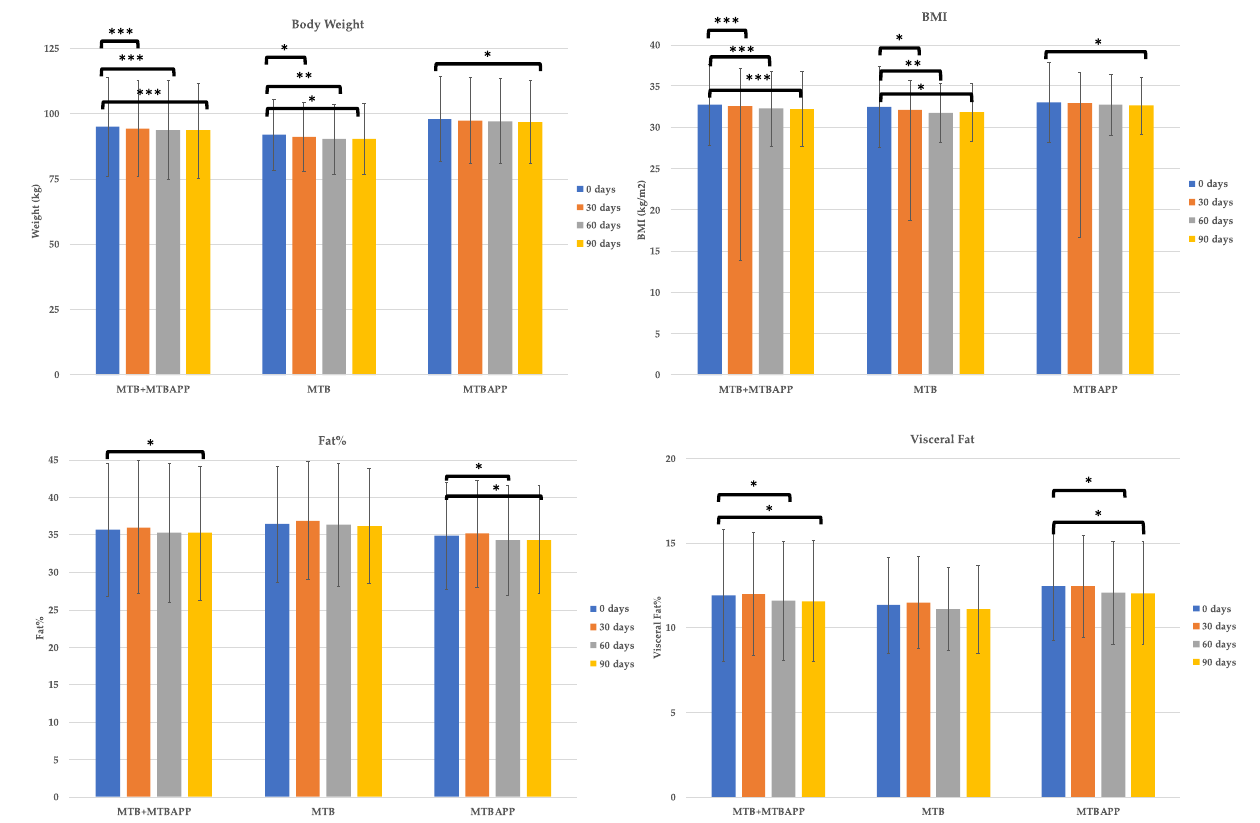
Figure 4. Body weight and body composition data. * p < 0.05, ** p < 0.01, and *** p < 0.005 by intragroup analysis.